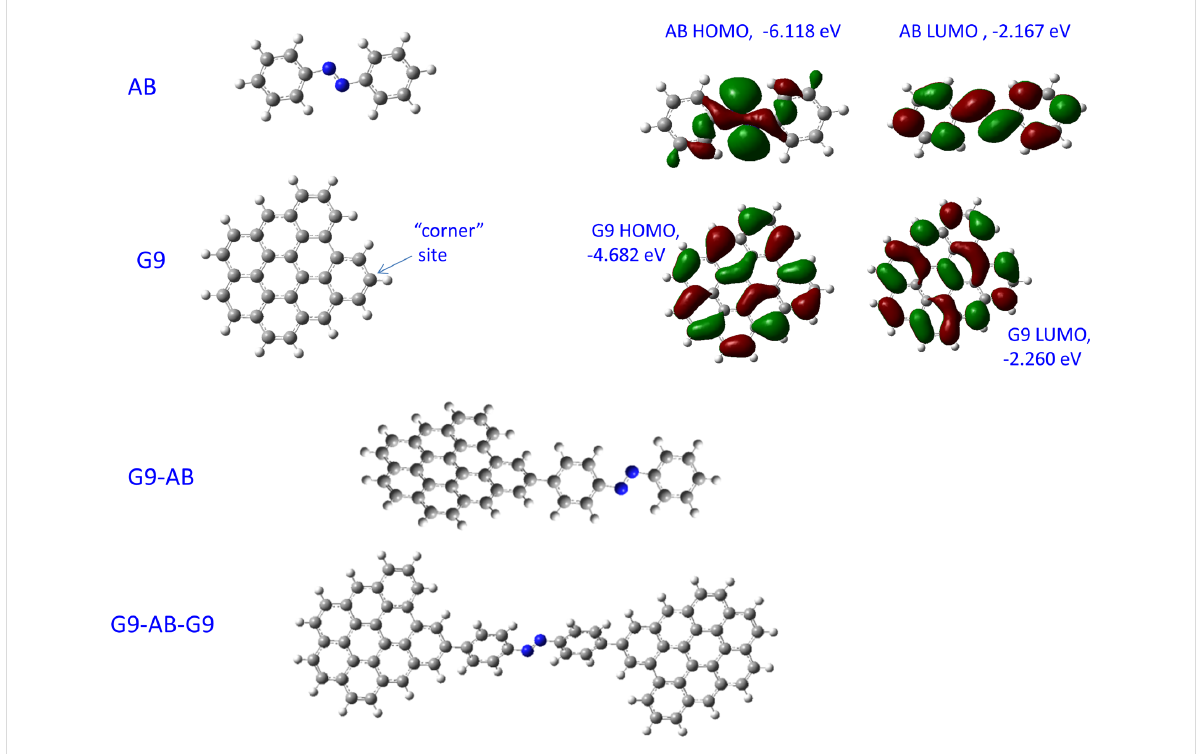
Figure 1: Structures of azobenzene (AB), 9-ring graphene fragment (G9), AB bonded to a G9 “corner” site (G9–AB), and AB bonded to two G9 rings to represent a carbon-based molecular junction (G9–AB–G9). Also shown are the HOMO and LUMO orbitals of isolated AB and G9, as